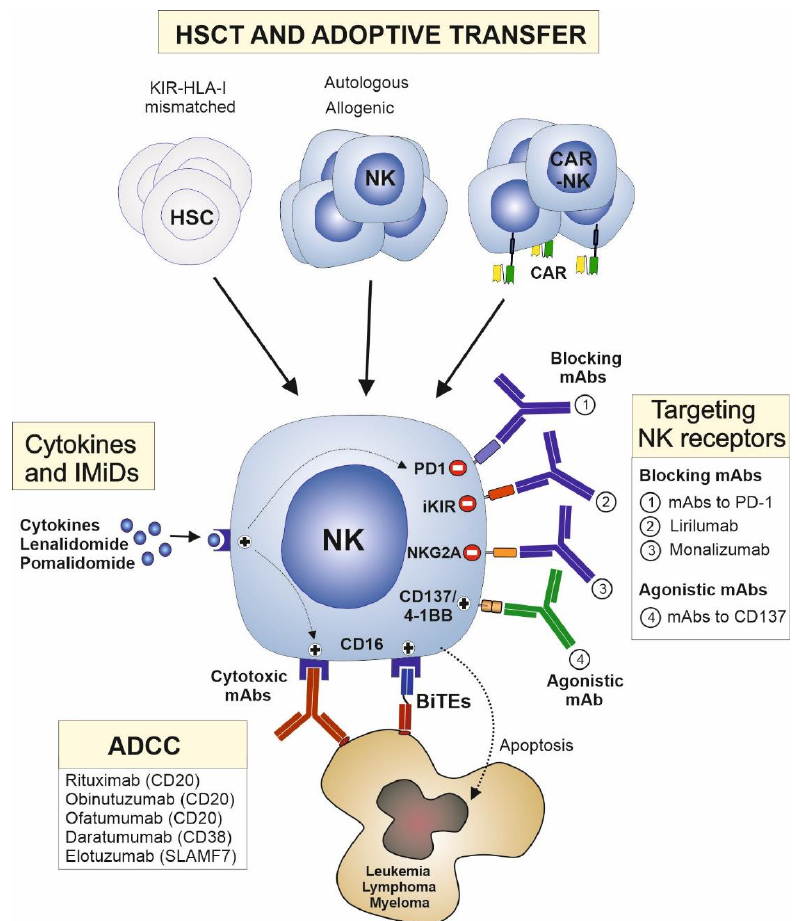
Figure 2. Therapeutic approaches involving natural killer (NK) cells to treat hematological cancers. Cytotoxic mAbs that engage CD16 receptors on NK cells and induce antibody-dependent cell-mediated cytotoxicity (ADCC) are the most widely used NK cell-based therapies in hematological cancers. The so-called bispecific antibodies (BITE) may improve ADCC activity by redirecting NK cells to tumor cells. NK cells, and particularly allogenic NK cells that are devoid of inhibitory KIRs for donor´s HLA class I molecules, play a key role in the therapeutic efficacy of hematopoietic stem cell transplantation (HSCT). Alternatively, NK cells may be expanded, activated, or redirected against cancer cells (chimeric antigen receptor (CAR)-NK cells) ex vivo and adoptively transferred to patients with hematological cancers. The antitumor activity of NK cells may also be stimulated by cytokines or immunostimulatory drugs such as lenalidomide or pomalidomide. Due to their capability of stimulating NK cell activity and ADCC, they may have synergistic e ff ects with therapeutic mAbs. Blocking antibodies directed against inhibitory NK cell receptors, including inhibitory KIRs (iKIR) (lirilumab) or natural killer group 2A (NKG2A) (monalizumab), and checkpoint proteins, including programmed death-1 (PD-1), have great clinical potential in this type of malignancies. Similarly, agonistic antibodies targeting T and NK cell costimulatory molecules, such as cluster of di ff erentiation 137 (CD137) / 4-1BB, are novel therapeutic alternatives for cancer therapy. HSC, hematopoietic stem cell; IMiDs, immunomodulatory drugs; mAbs, monoclonal antibodies. SLAMF7, SLAM family member